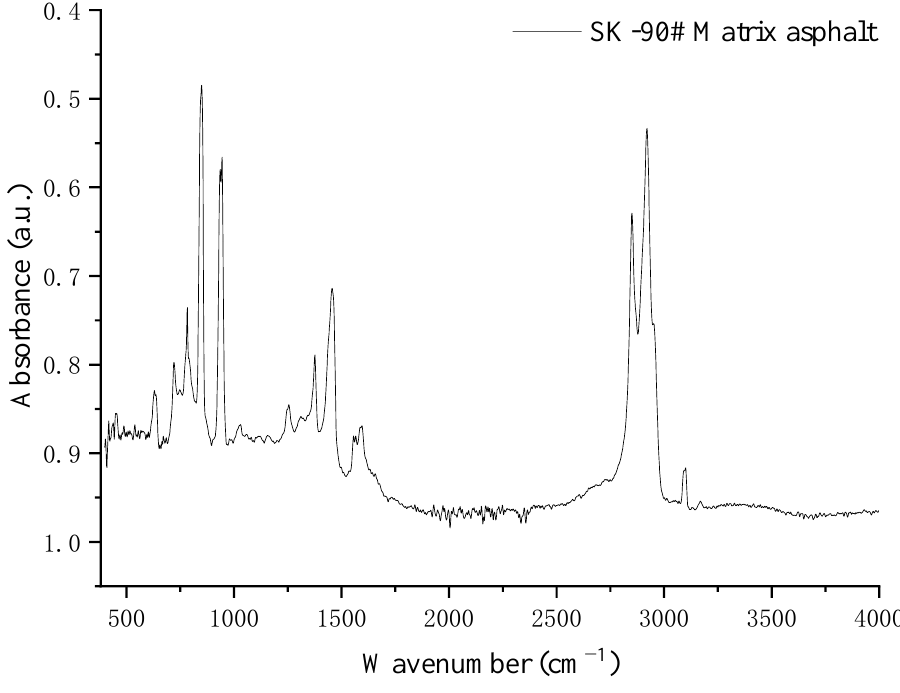
Figure 6. FTIR image of SK-90# matrix asphalt.